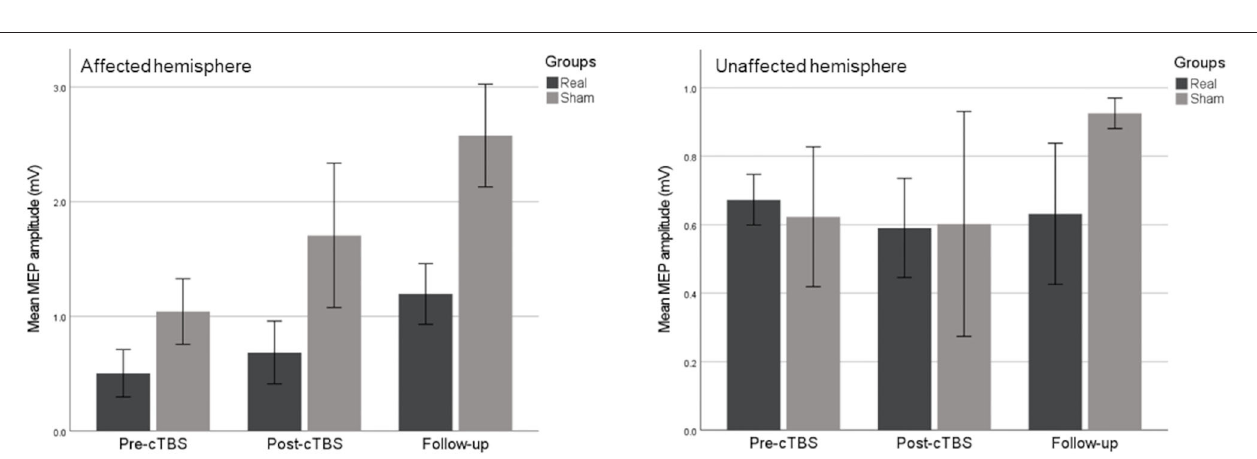
FIGURE 3 | Scores in the Wolf Motor Function Test log performance time (left chart) and functional ability scale (right chart) , throughout the three time points. Error bars depict ± 1 SE.